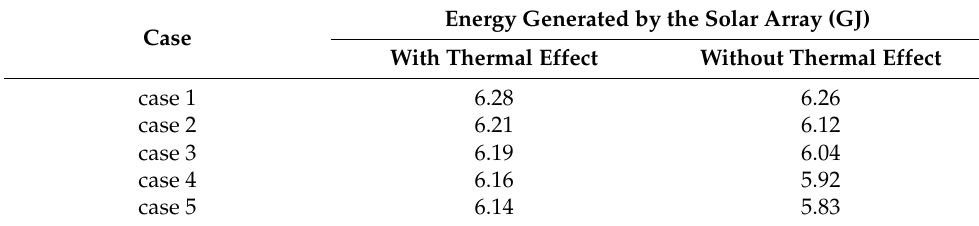
Table 4. Energy generation on the winter solstice with different